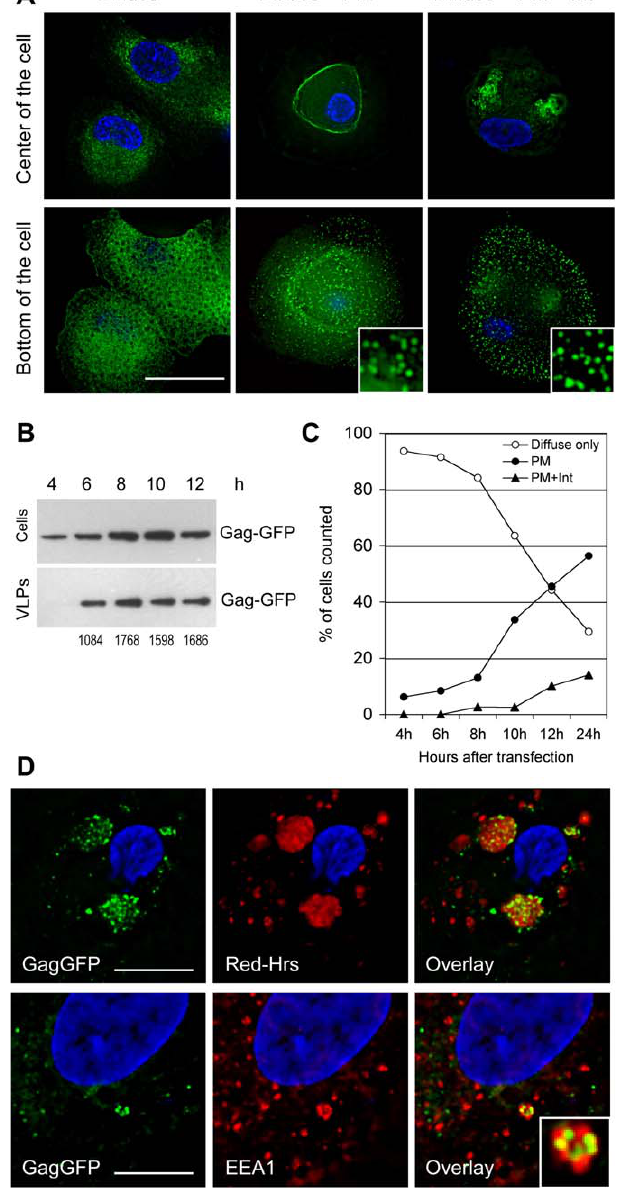
Figure 6. HIV-1 Gag Accumulation at the PM Precedes Accumulation in Primary Human Macrophage Endosomes (A) Distribution of Gag-GFP in macrophages. Cells expressing Gag-GFP (green) were fixed at 24-h post-transfection and stained with Hoechst 33258 (blue). Examples of cells exhibiting diffuse Gag only (left), PM accumulations (center), or PM þ internal (Int; right) accumulations are shown. Insets show individual Gag-GFP puncta at the PM coverslip interface. Scale bar indicates 10 l m. (B) Western blot analysis of macrophages expressing Gag-GFP. Samples were collected every 2 h, from 4- to 12-h post-transfection. Cell and extracellular particle lysates were probed with anti–HIV-1 CA antibodies. Numerical values below the blots indicate VLP signal intensities, derived by densitometry. (C) Quantification of Gag-GFP distribution in macrophages. The proportion of cells (of 100 counted at each time point) in which Gag- GFP was observed in accumulations only at the PM, as internal and PM accumulations, or as a diffuse cytoplasmic signal only were counted. (D) Intracellular Gag-GFP is observed on early and late endosomes in macrophages. Cells expressing Gag-GFP (green) were fixed at 24-h post- transfection and stained with anti-EEA1 (red). Alternatively, cells were co- transfected with mRed-Hrs (red). Inset in the bottom right panel shows an individual EEA1 þ endosome and associated Gag-GFP. Scale bars indicate 10 l m (top panel) and 4 l m (bottom panel). DOI: 10.1371/journal.pbio.0040435.g006 PLoS Biology |